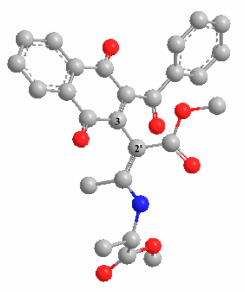
Figure 3. Molecular model of one conformational isomer of 6